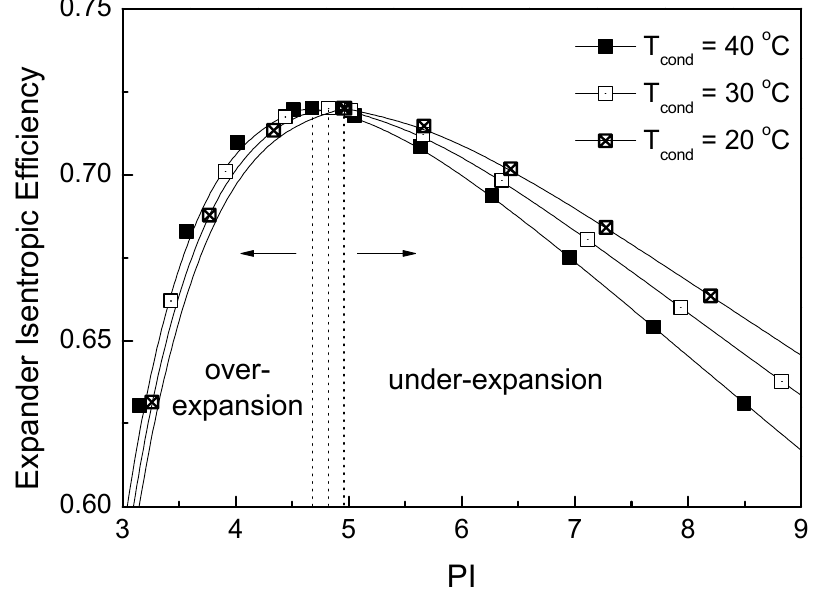
Figure 4. Modeled effects of PI and supply pressure on expander isentropic